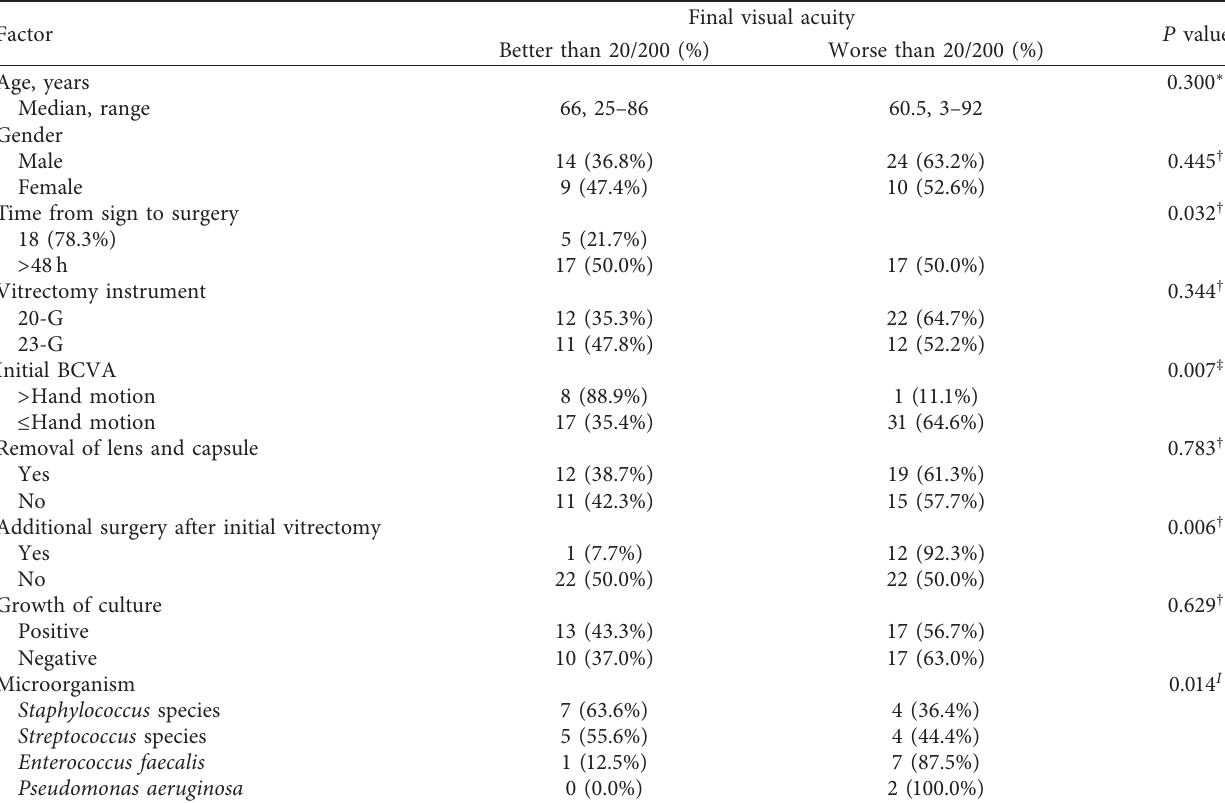
Table 4: Factor associated with final visual acuity.